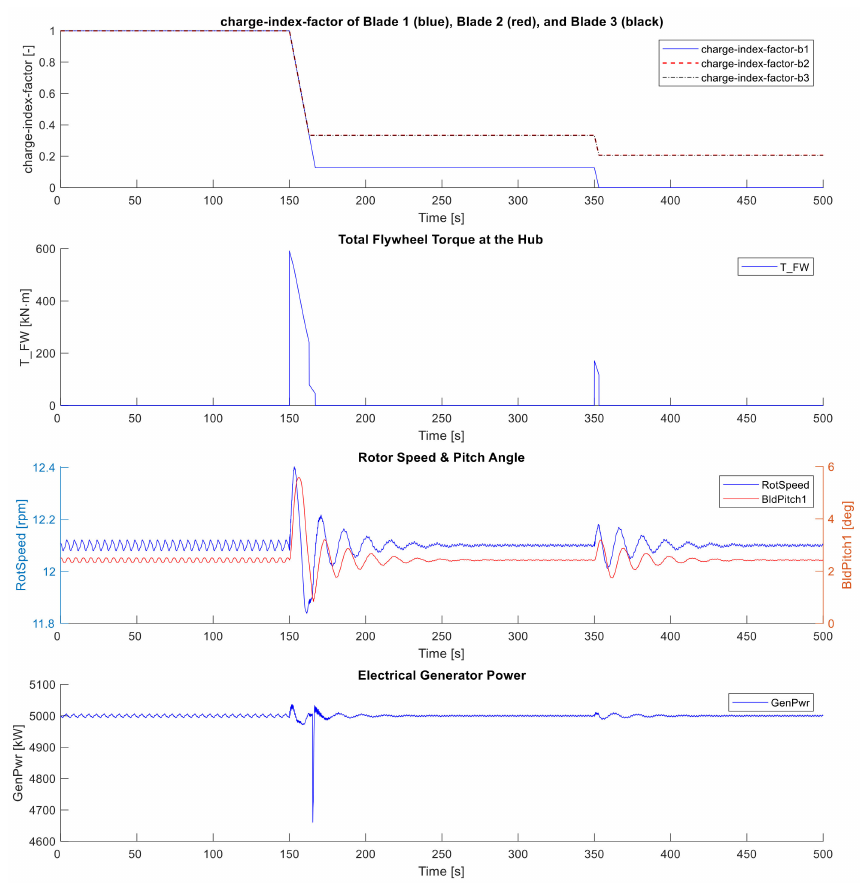
Figure 10. Impact of the flywheel torque on rotor speed and generator